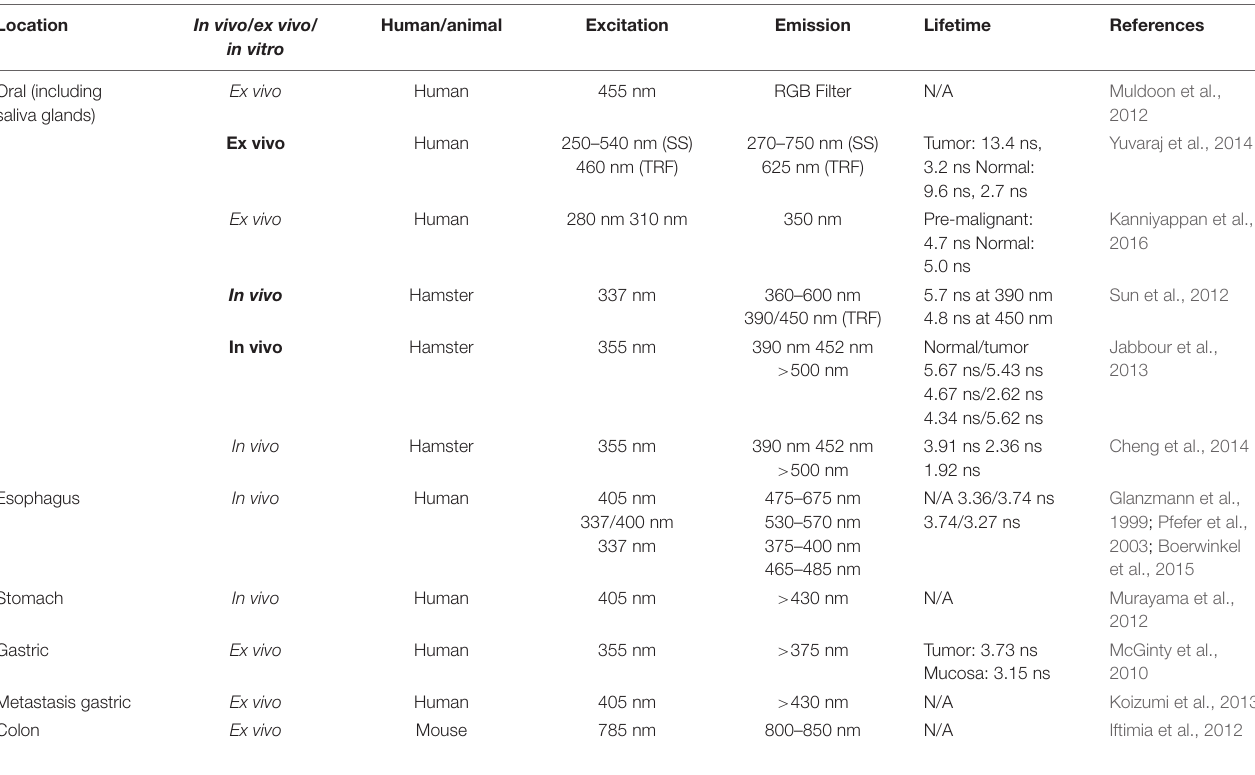
TABLE 2 | Steady-state (SS)/time-resolved fluorescence (TRF) approaches for GI optical biopsy. Location In vivo / ex vivo / in